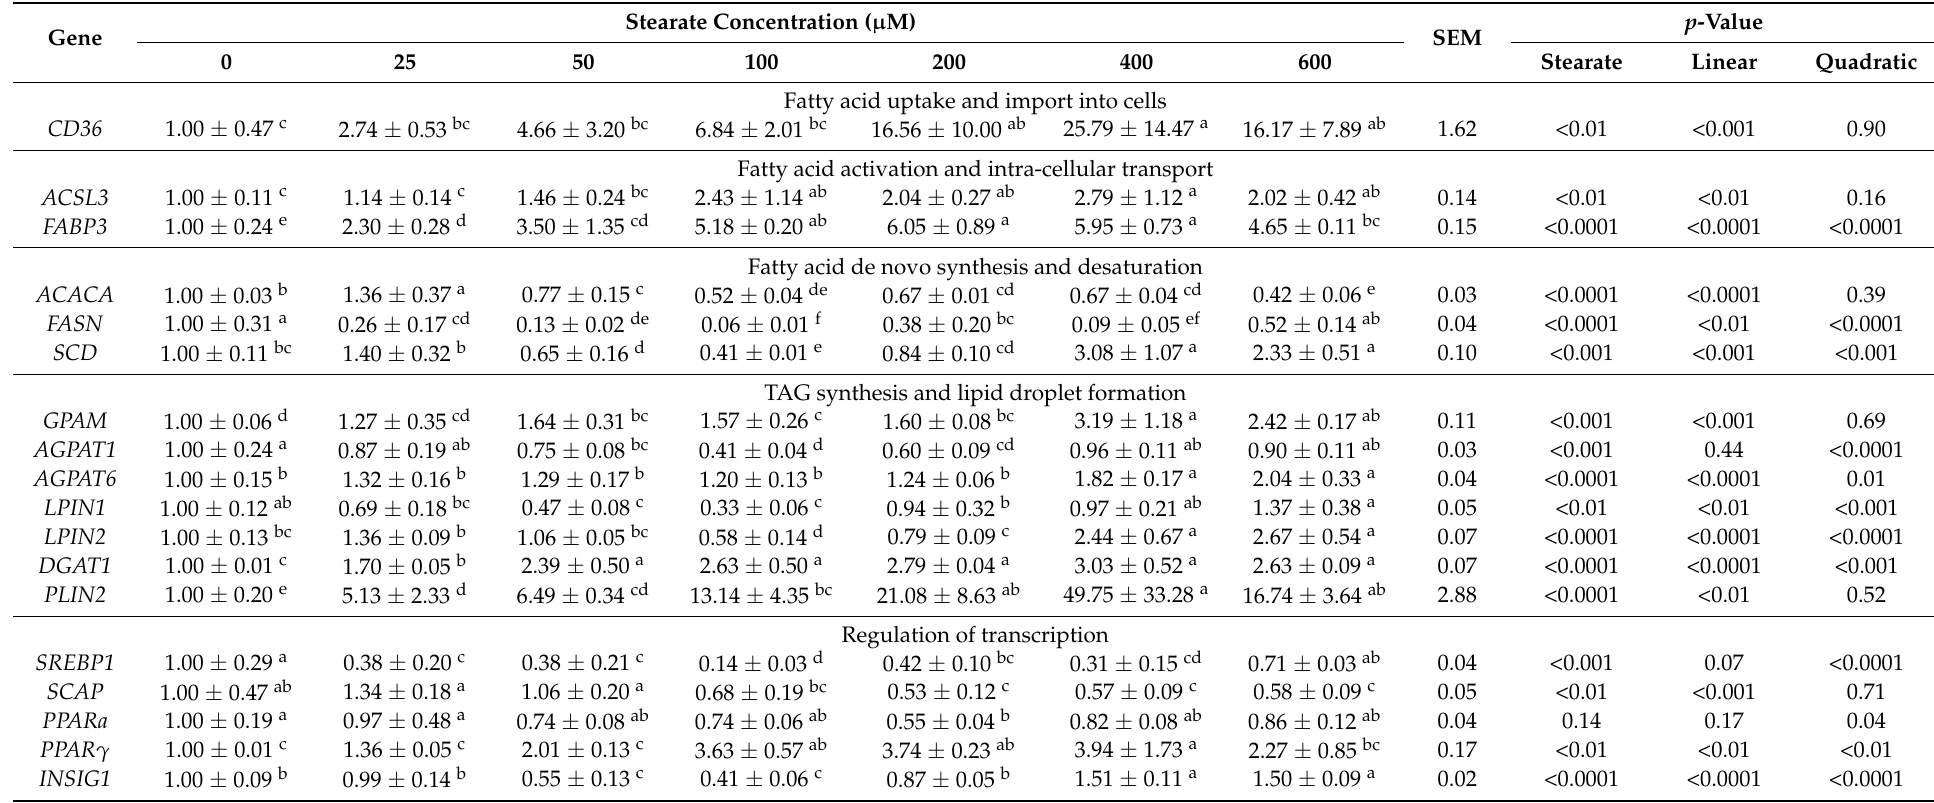
Table 1. Effect of stearate on mRNA expression of genes involved in lipid synthesis in pMECs 1.